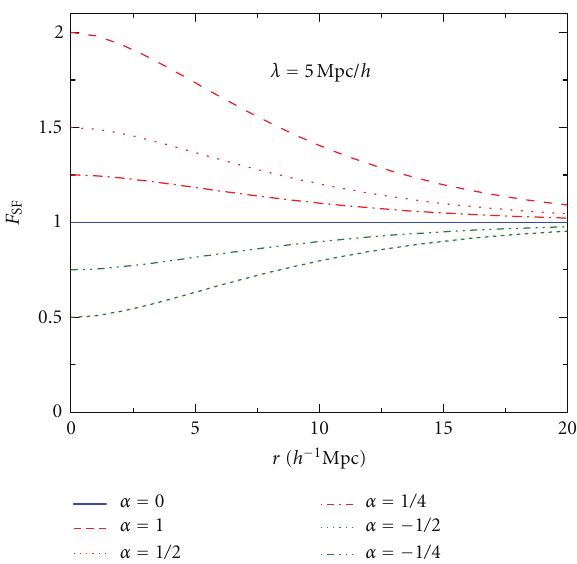
Figure 2: Function F SF ( r , α , λ ) for λ = 5Mpc /h and several values of parameter α . α = 0, That is, the standard Newtonian case is the horizontal line. The long dashed line above the horizontal standard line is for α = 1. The dotted line is for α = 1 / 2, and the dotted- dashed line is for α = 1 / 4. For negative values of α the lines are below the standard horizontal case. Small dashed line is for α = − 1 / 2 and the double-dotted-dashed line is for α = − 1 /